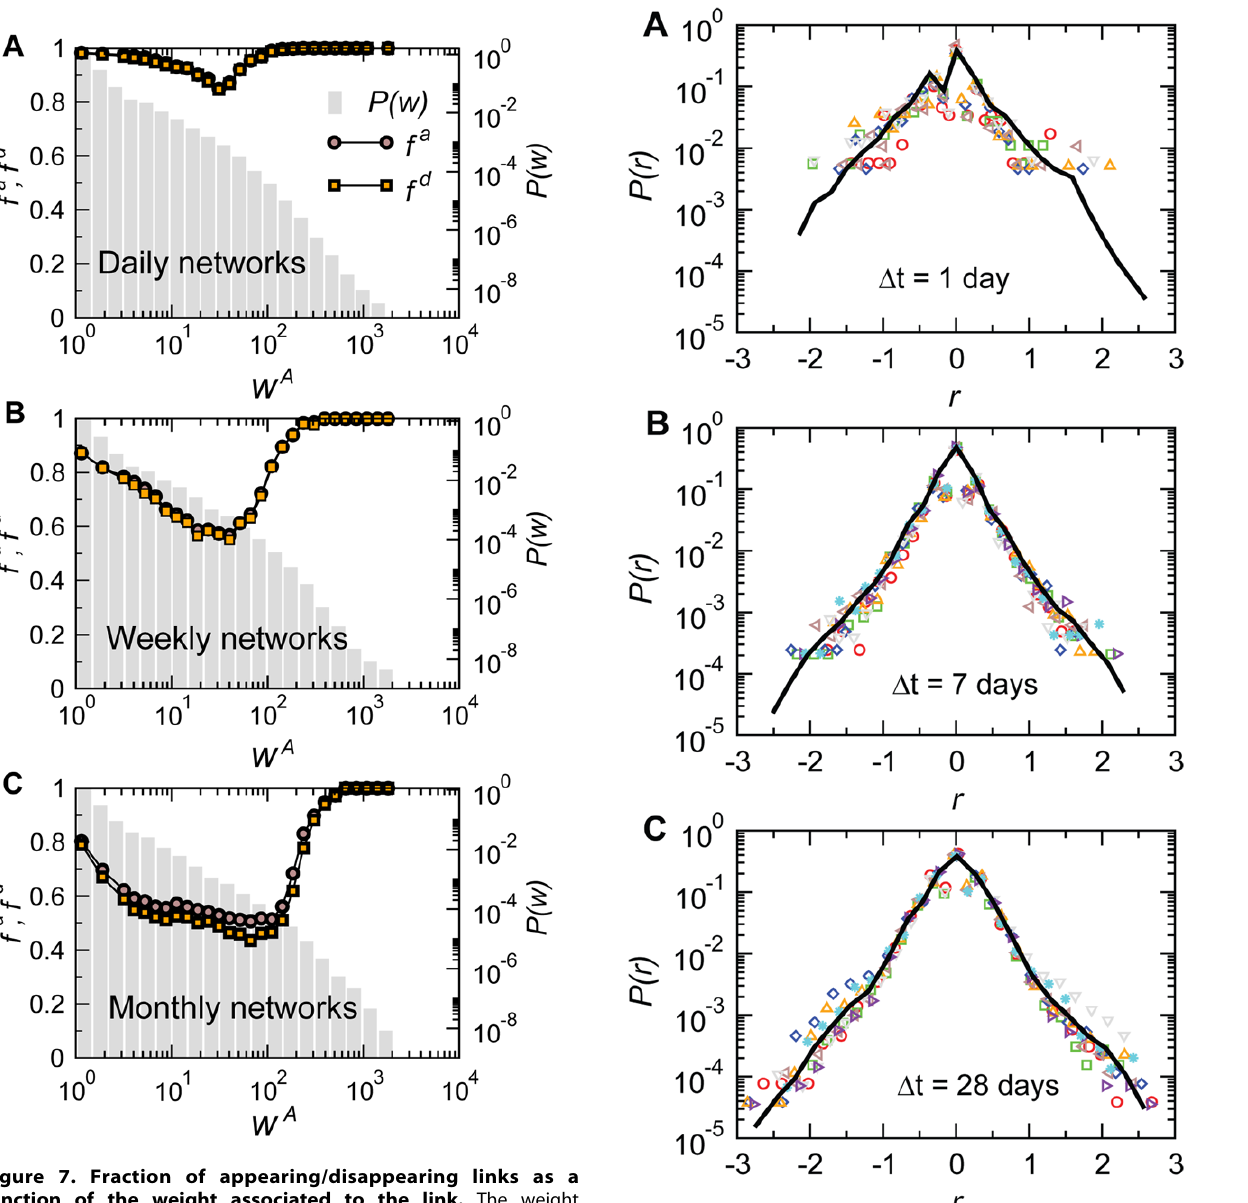
Figure 7. Fraction of appearing/disappearing links as a function of the weight associated to the link. The weight considered here counts the number of animals, w A . Results for daily, weekly, and monthly networks are shown (panels A, B, C, respectively). As a reference, the weight distribution is also shown with a grey histogram.